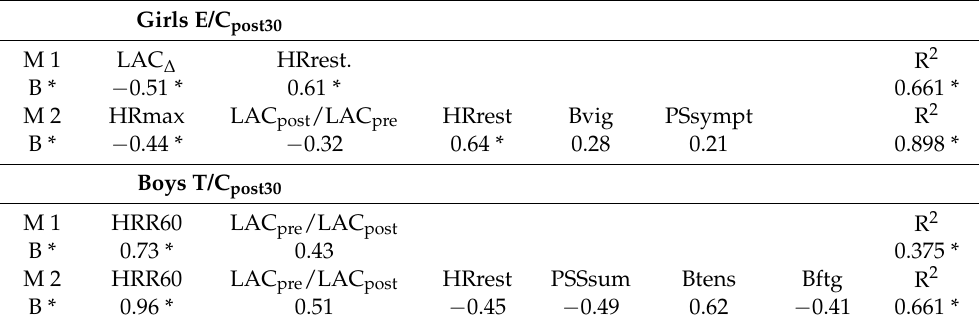
Table 2. Multivariate analysis of girls’ and boys’ E/C or T/C ratios after the exercise. Girls E/C